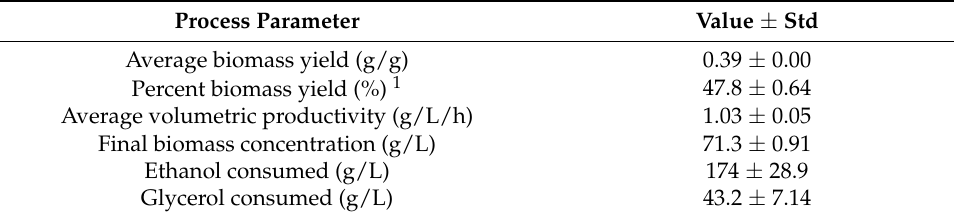
Table 3. Relevant process parameters observed during propagation of S. cerevisiae cV-110 on ethanol and glycerol in fed-batch mode in an automatic bioreactor